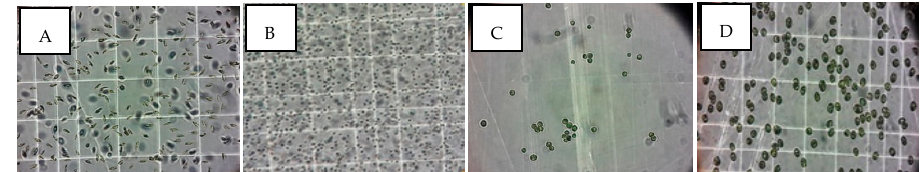
Figure 5. Light microscopic observation of isolated microalgae: ( A ) Phaeodactylum tricornutum ( B ) Nannochloropsis gaditana , ( C ) Nannochloris sp, and ( D ) Tetraselmis suecica .